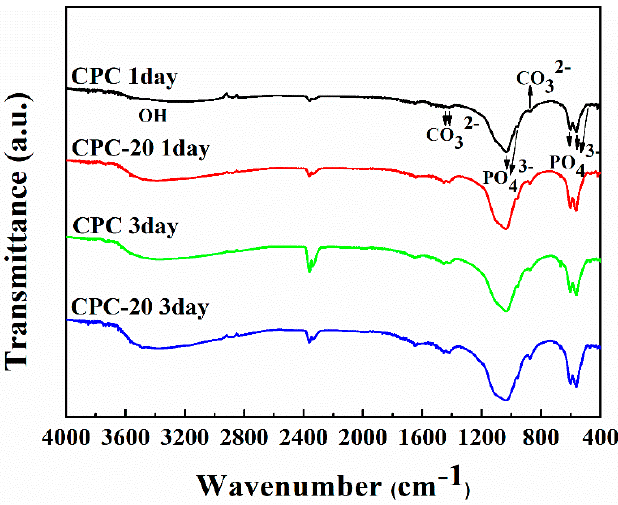
Figure 11. FTIR spectra of sample CPC and CPC-20 after immersion for one day and three days.